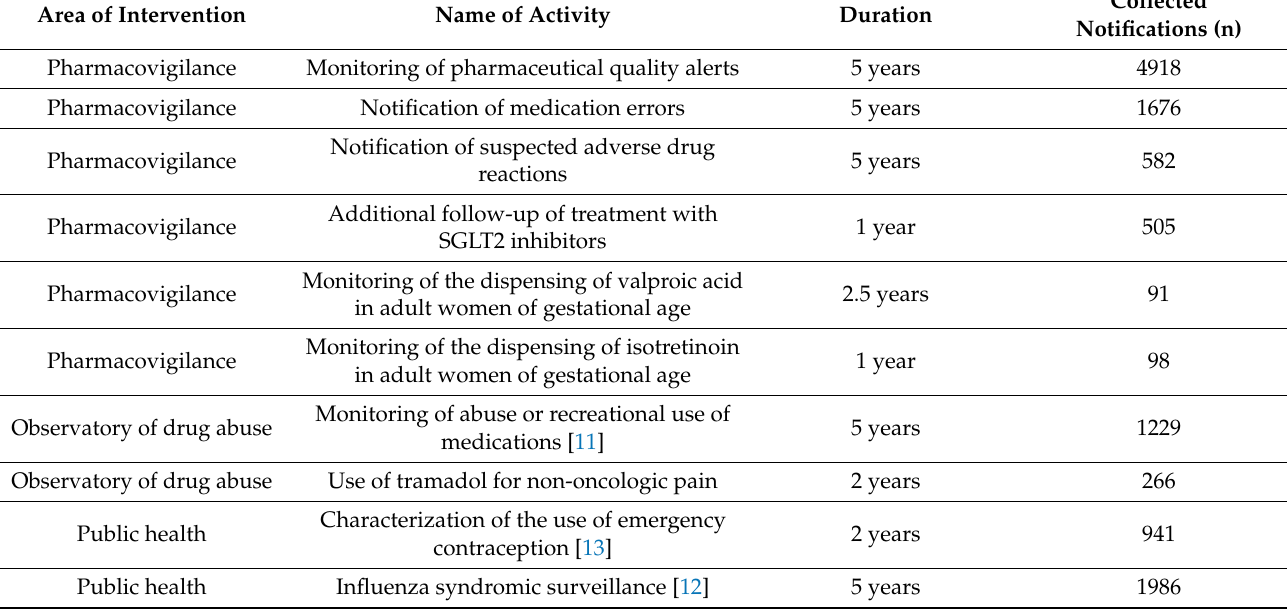
Table 4. Activities carried out for the network of sentinel pharmacies in Catalonia during the 2017–2021